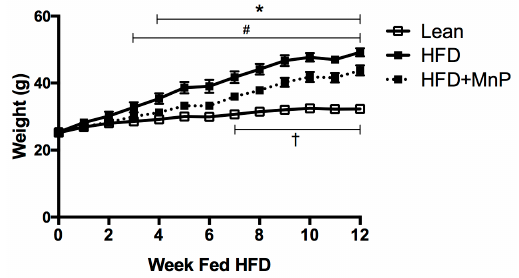
Figure 2. MnP treatment reduces weight gain in high fat diet (HFD)-fed mice. Over 12 weeks of HFD feeding, weights were recorded for Lean (empty squares, solid line), HFD (filled squares, solid line), and HFD + MnP (filled squares, dashed line) mice, n = 5 mice per group. Data is displayed as mean ± SEM. Significance was calculated by two-way ANOVA with a Tukey post-test of multiple comparisons. Significant differences were observed between Lean and HFD starting at 3 weeks (#), between HFD and HFD + MnP starting at 4 weeks (*), and between Lean and HFD + MnP starting at 7 weeks (†), all lasting the duration of the experiment.